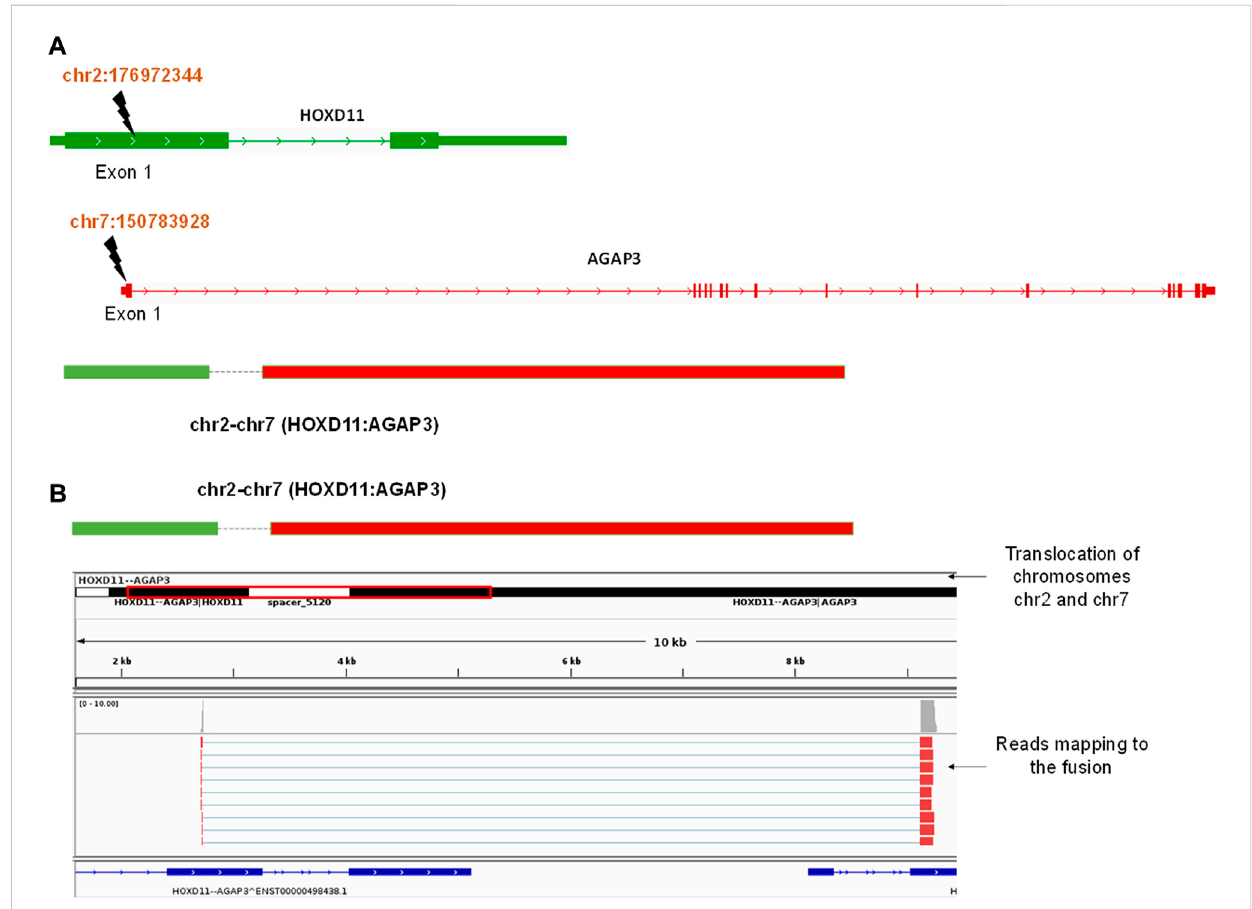
FIGURE 2 (A) AdiagrammaticrepresentationofHOXD11-AGAP3fusionfromchr2andchr7respectivelyatthereportedlocationsofExon1ineachgene. (B) An IGV snapshot showing the HOXD11-AGAP3 fusion transcript with reads from the alignment fi le mapping to the